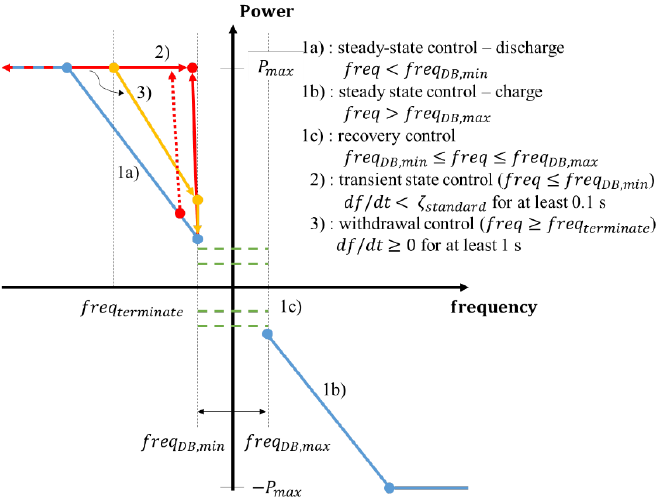
Figure 2. Simplified control scheme of the performance maximizing (PM) control method, Reprinted from Ref. [35].